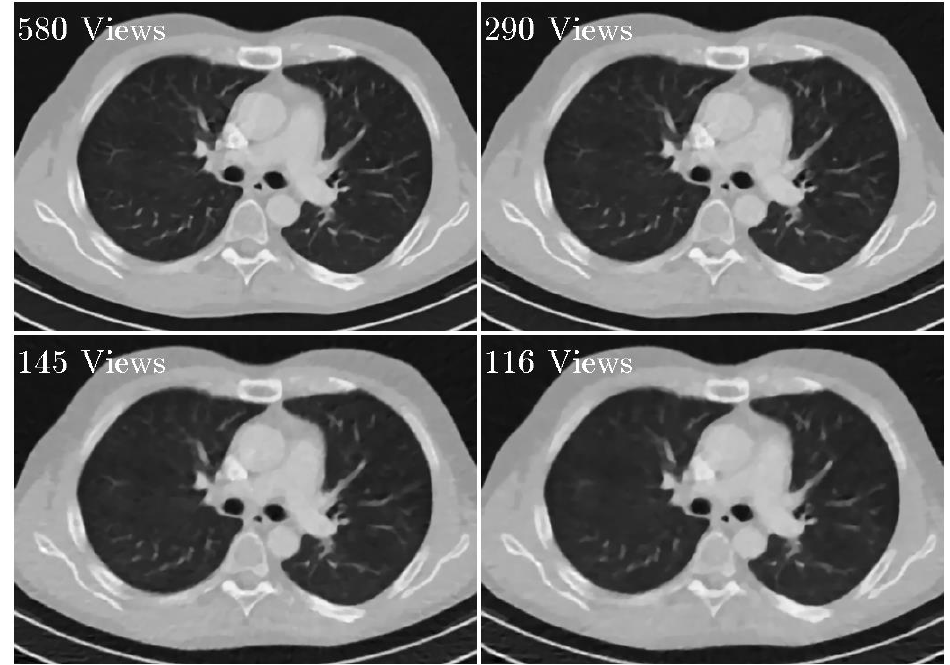
Figure 9. Reconstructed images using the SIR-STV 1 method with respect to different views. The display window is [–1000, 667] HU.